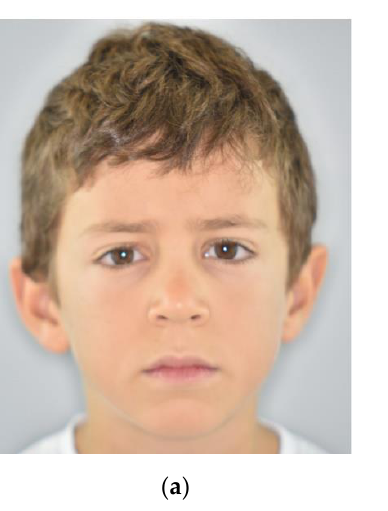
Figure 7. Extraoral post-treatment pictures: ( a ) frontal view; ( b ) lateral view.